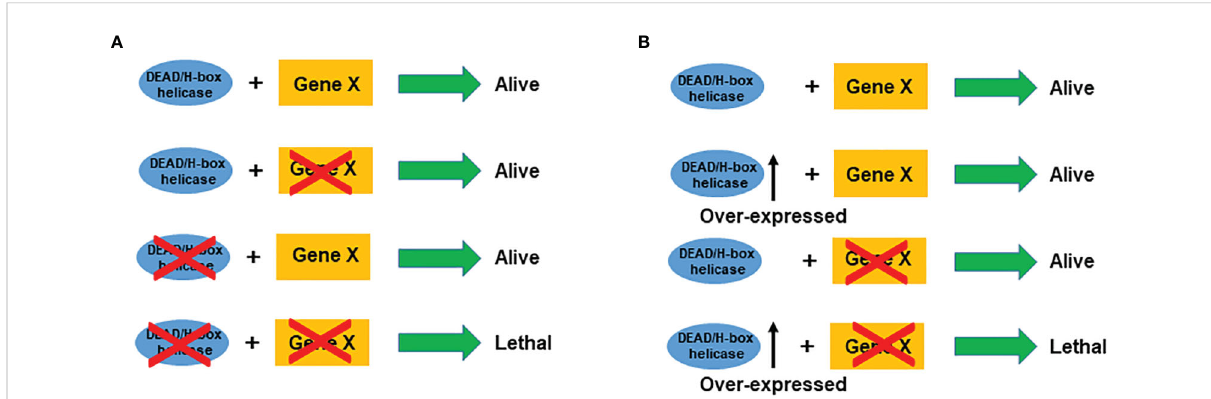
FIGURE 3 Schematic illustration of synthetic lethality (A) and synthetic dosage lethality (B) for DEAD/H-box helicases. Cross on a gene stands for mutation or